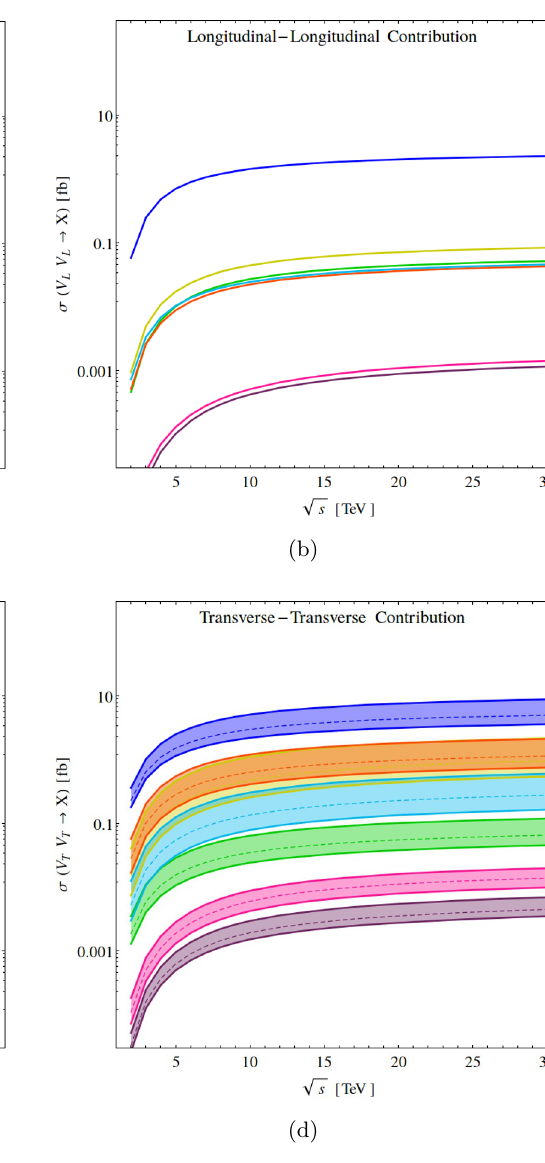
Figure 8 . Same as figure 7 but for tt pair production and tt + X associated